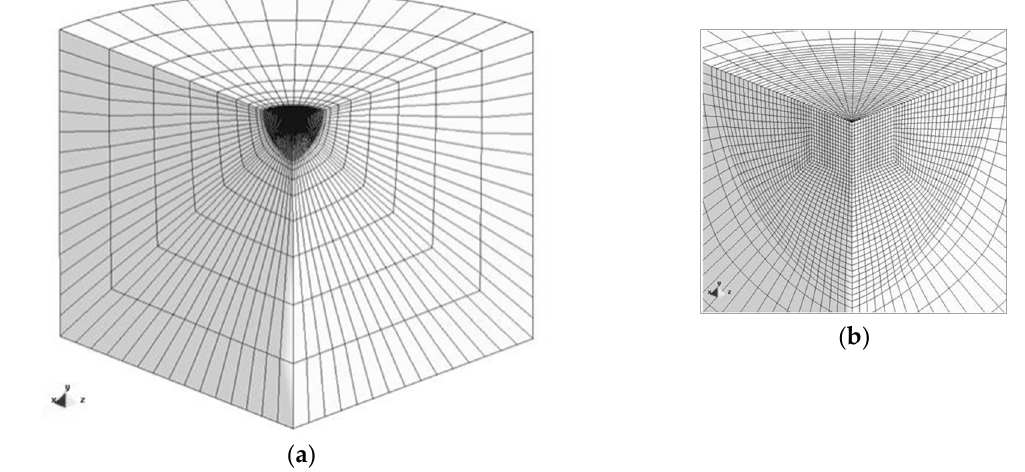
Figure 4. Finite element mesh used in the numerical simulations: ( a ) global view; ( b ) detail of the central region where indentation occurs